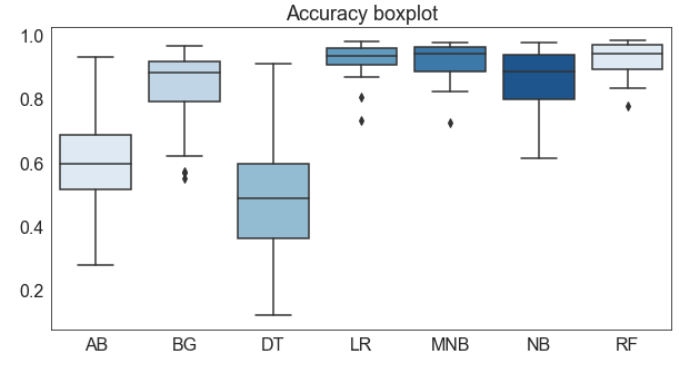
Figure 11. Accuracy